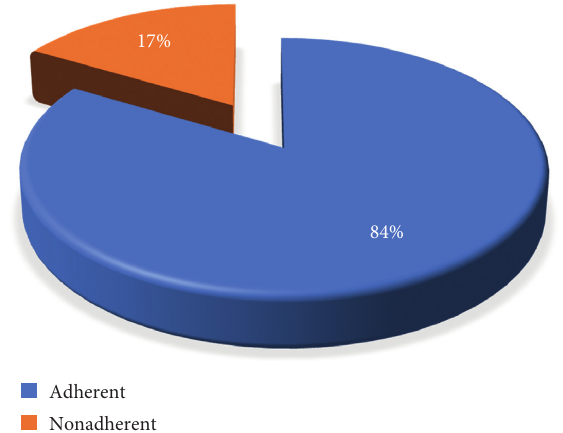
Figure 2: The level of nonadherence to antihypertensive medi- cations among hypertensive patients in a follow-up clinic at Asella Referral and Teaching Hospital, Asella Town, Arsi Zone, Oromia Regional State, Ethiopia, 2020 ( n �